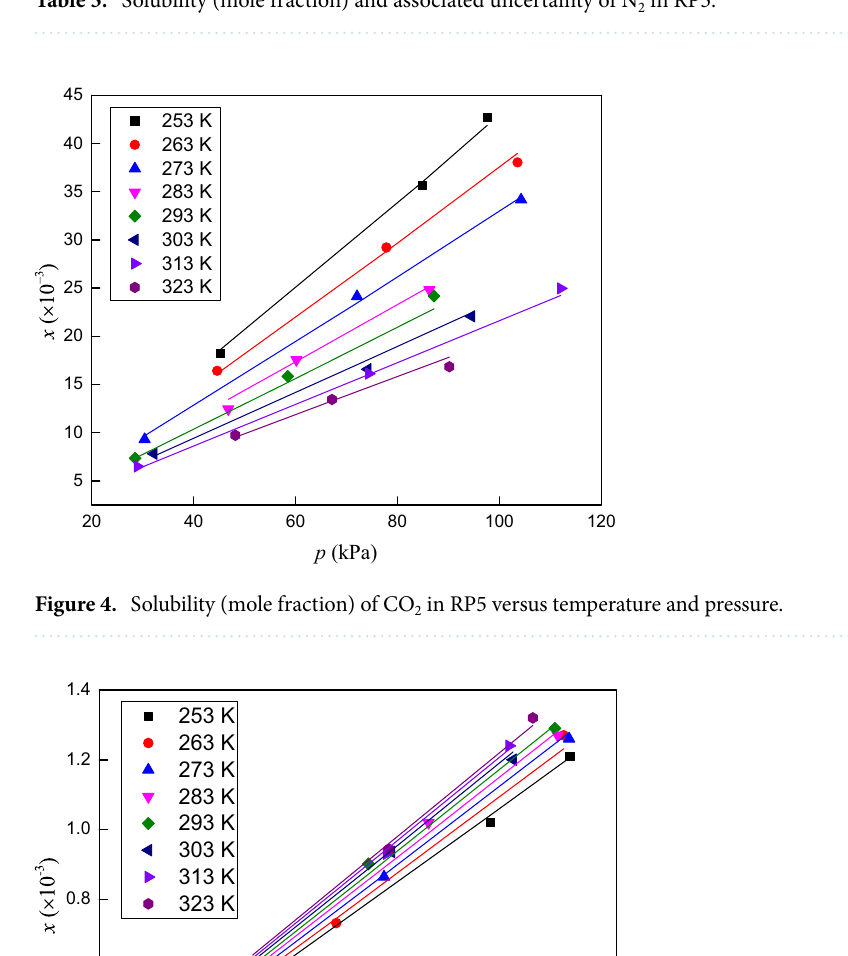
Table 5. Solubility (mole fraction) and associated uncertainty of N 2 in RP5.